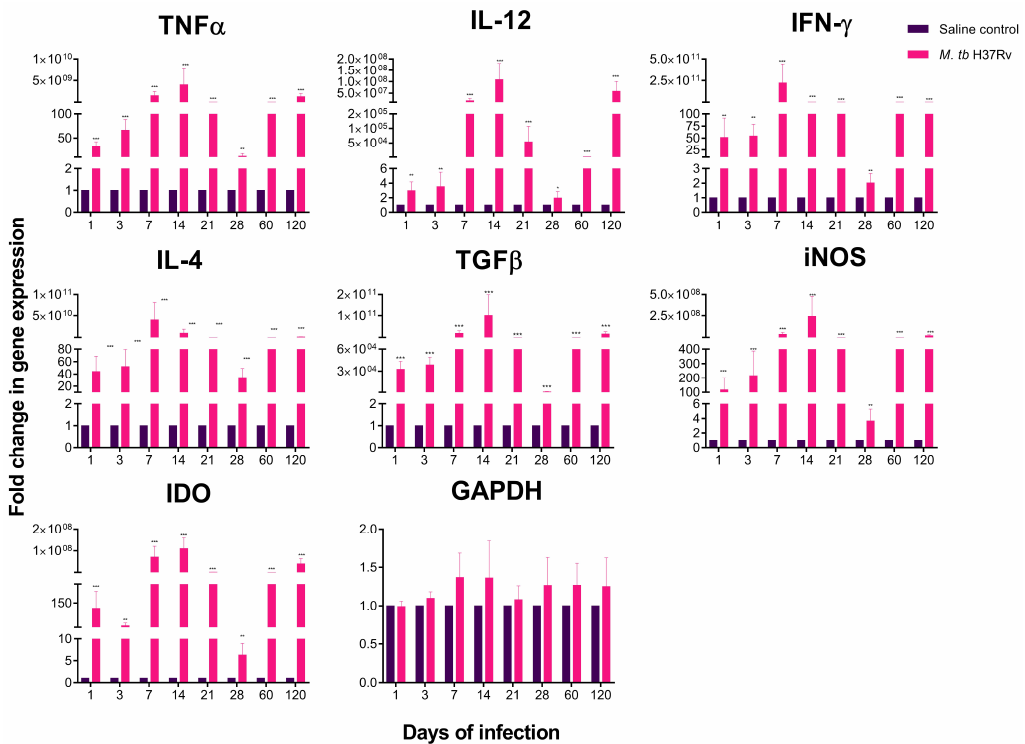
Figure 3. Cytokine and enzyme expression of the hippocampus of mice intratracheal infected with M. tb H37Rv. In the absence of any detectable brain infection, there was a significant increase in gene expression from day 1 post-infection, being the highest on days 7 and 14 post-infection. Saline controls were mainly una ff ected. RNA was isolated from hippocampus homogenates and reverse-transcribed to cDNA, then analysed for changes in gene expression determined by RT-PCR of the indicated cytokine or enzyme. Fold-change values were normalised to expression levels of the saline controls. Data are expressed as mean ± SEM. TNF α F (1, 10) = 81.02, p < 0.0001, two-way ANOVA; ** p < 0.001, *** p < 0.0001 Sidak’s multiple comparisons test ( α = 0.05) ( n = 6). IL-12 F (1, 10) = 59.7, p = 0.0032, two-way